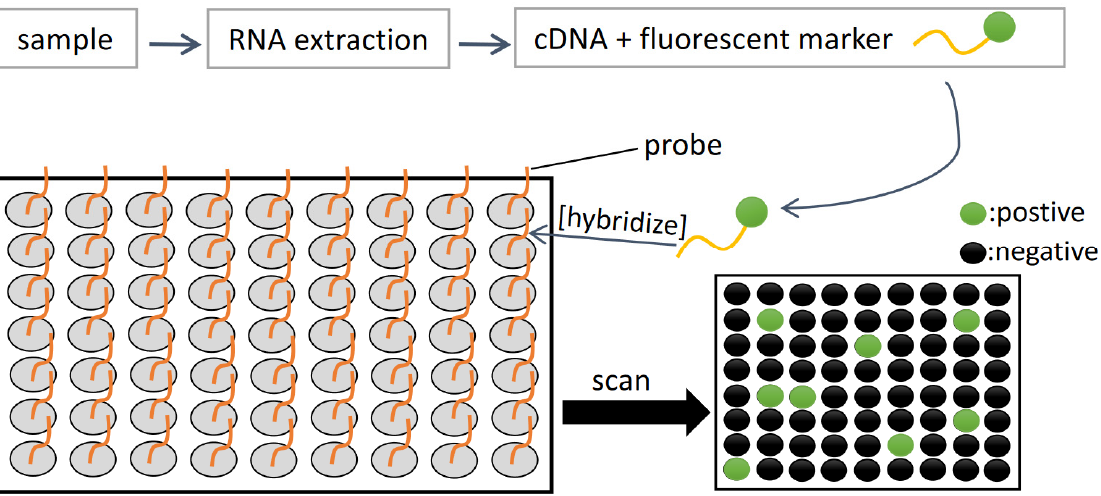
Figure 6. Basic principle of microarray.